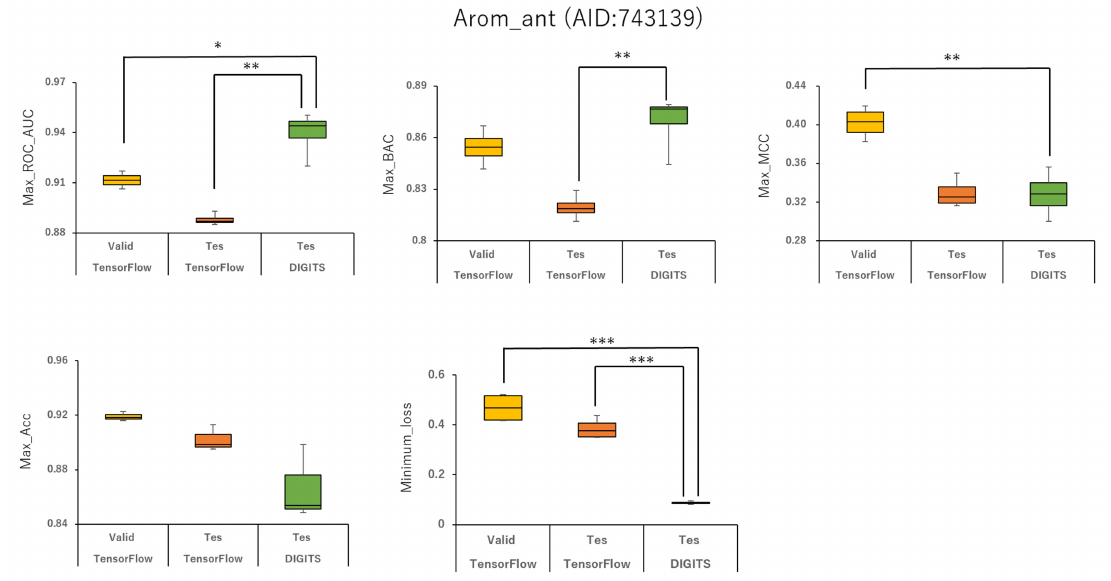
Figure 9. Max ROC_AUC, max BAC, max MCC, max Acc, and minimum loss of Arom_ant (AID:743139) in validation and test datasets in TensorFlow and test dataset in DIGITS. ** p < 0.01, *** p < 0.001 for t